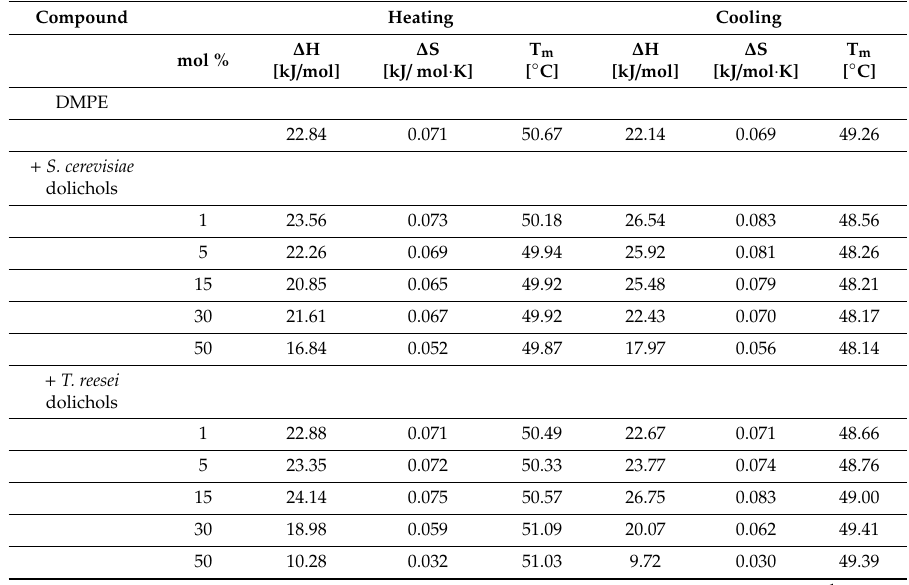
Table 5. Thermodynamic parameters of fully hydrated multilamellar 1,2-dimyristoyl- sn -glycero- 3-phosphatidylethanolamine (DMPE) liposomes supplemented with S. cerevisiae or T. reesei dolichols.